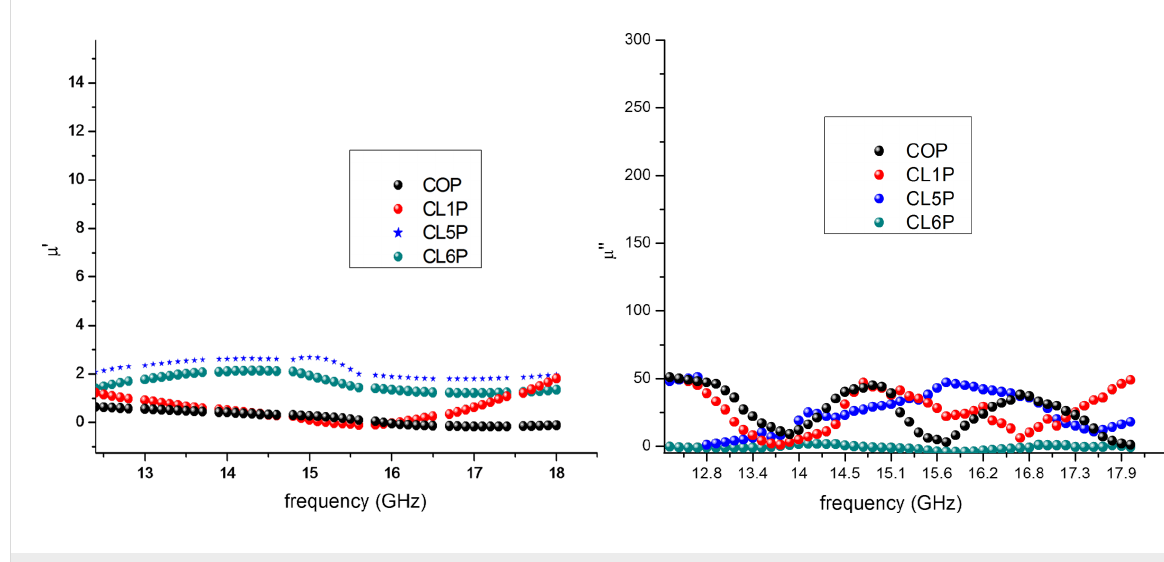
Figure 7: Real (µ ′ ) and imaginary part (µ ″ ) of the complex permeability (µ).